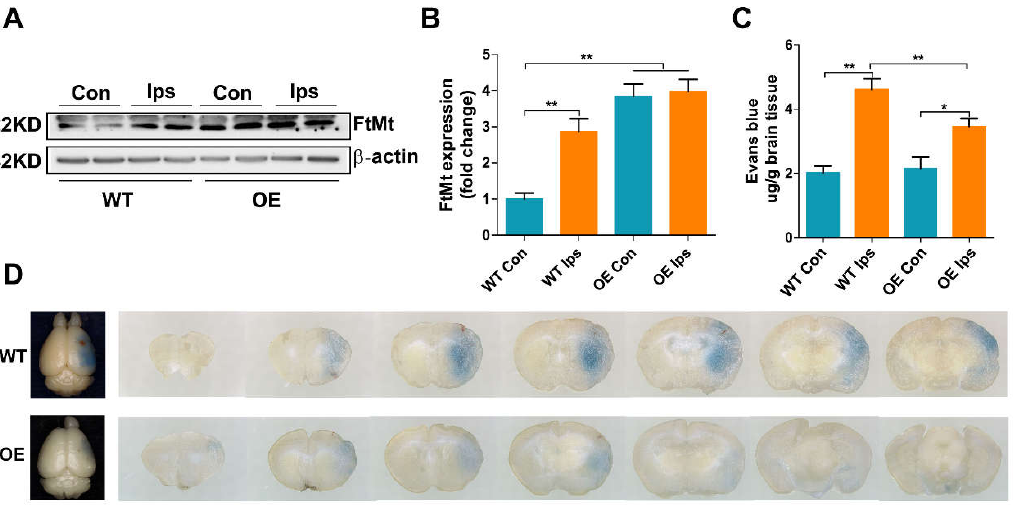
Figure 1. Overexpression of FtMt attenuates I/R-induced BBB disruption. ( A ) Ischemic stroke was induced in wild-type mice (WT) and FtMt-overexpressing mice (OE) by MCAO for 60 min with a subsequent 24 h reperfusion. The expression of FtMt in the contralateral hemisphere (Con) and ip- silateral hemisphere (Ips) was measured. ( B ) Quantification of FtMt levels. The data are expressed relative to the mean value in the WT Con group ( n = 4). ( C ) Quantification of Evans blue dye extrav- asation in WT or OE mice after I/R ( n = 4). ( D ) Representative images of Evans blue dye extravasation in WT or OE mice after I/R. The results are presented as the mean SEM. * p < 0.05, ** p < 0.01.